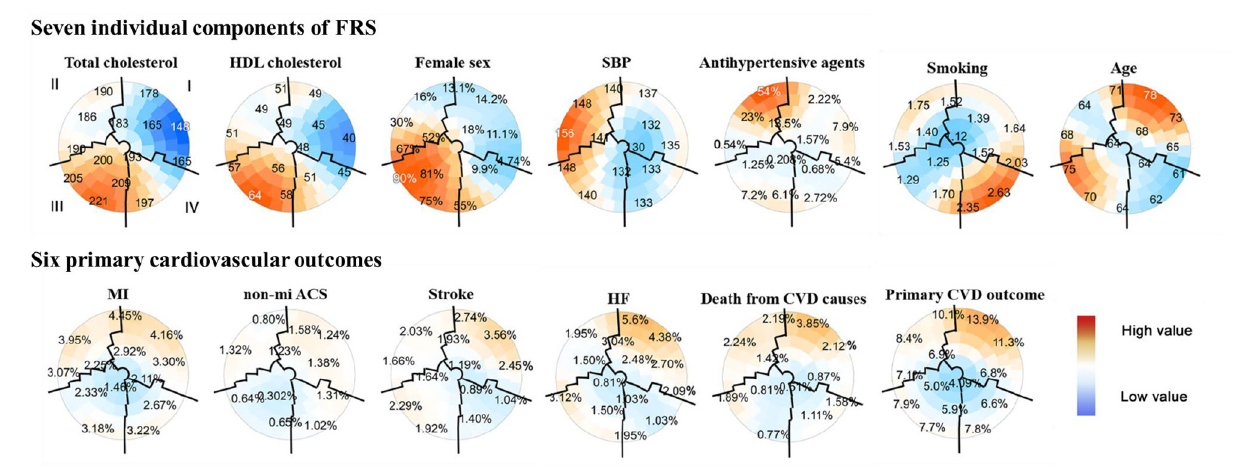
FIGURE 2 | Subgrouping results from seven individual components of the FRS and six primary cardiovascular outcomes using the SOM in the SPRINT data ( n = 8,773). Each component plane aforementioned showed coloring on the same SOM. The upper part of the two-dimensional SOMs were seven components of the FRS, including TC, HDL cholesterol, female, SBP, antihypertensive agents use, smoking status, and age. Six cardiovascular outcomes included MI, non-MI ACS, stroke, HF, death from CVD causes, and a composite cardiovascular outcome were in the lower part of the figure. The position for each participant on the map was unique and only dependent on the seven individual components of the FRS, so each participant was always located in the same place on each map. The color scale indicates the deviation from the population mean concerning the random fluctuations that could be expected by chance; dark red indicated the highest and dark blue for the lowest values. The numbers on the map represented the local mean value or prevalence (binary variables) for that region. Close districts were selected based on visual identification to provide relevant subgroups of individuals whose boundaries were marked by black lines. A total of four population subgroups were determined: subgroup I was characterized by men with the lowest TC and HDL-C, while subgroup III was women with the highest mean TC and HDL-C; subgroup II had the highest mean SBP with no antihypertensive medication use at the baseline visit, and subgroup IV characterized by mostly younger patients with antihypertensive medication use and smoking history. Patients with similar components of FRS were located close to each other throughout the map. SPRINT, systolic blood pressure intervention trial; FRS, framingham risk score; SOM, self-organizing maps; HDL, high-density lipoprotein cholesterol; SBP, sys tolic blood pressure; MI, myocardial infarction; non-MI ACS, nonmyocardial infarction acute coronary syndrome; HF, heart failure; CVD, cardiovascular